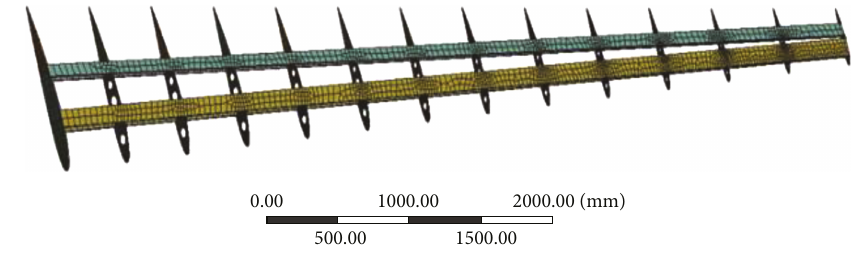
Figure 6: Internal fi nite element mesh. Table 5: Mechanical properties of the skins with di ff erent